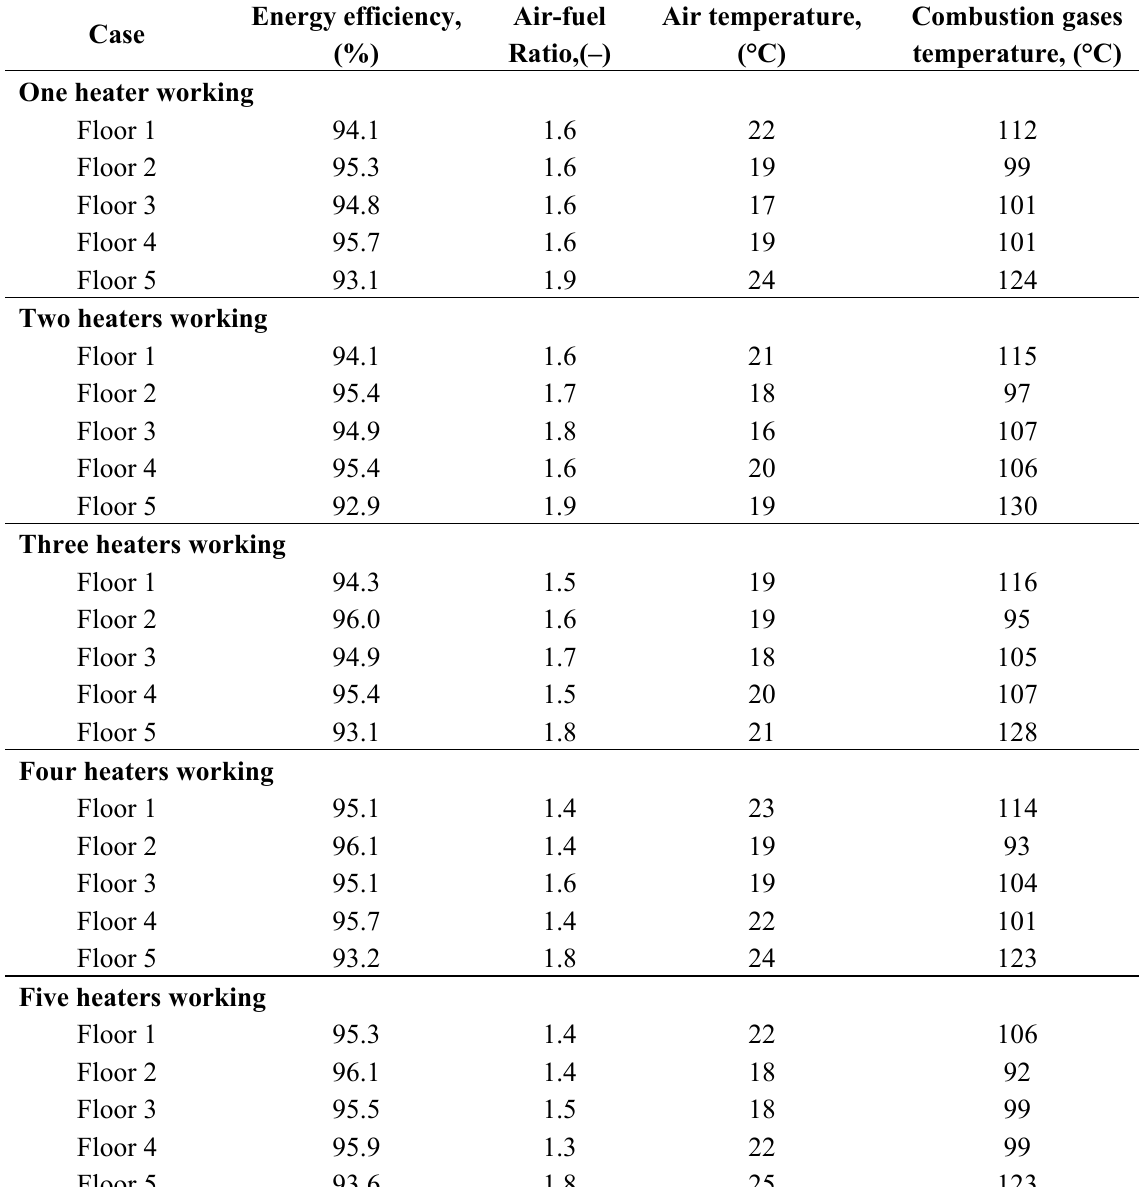
Table 5. Experimental results for the separate system in multi-story